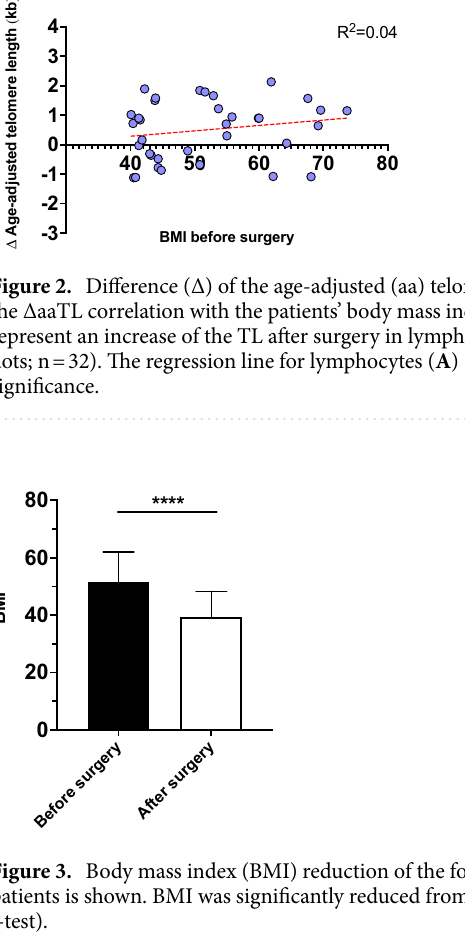
Fig. 1A (lymphocytes; blue dots) and Fig. 1B (granulocytes; yellow dots), compared to healthy individuals shown as percentile curves as used in previous publications 42,44 . No patient showed TL below the 1st percentile as a potential indicator of an inherited TBD. Compared to healthy controls, the lymphocyte aaTL of all patients before surgery was significantly shortened (-0.37 kb ± 0.18 kb, P = 0.045; Fig. 1C), while the granulocyte aaTL was not different (0.28 kb ± 0.17 kb, P = 0.11; Fig. 1C). Moreover, the lymphocyte TL was significantly shorter than that of the granulocytes (mean difference 0.65 kb ± 0.23 kb, P = 0.0041, Fig. 1C). Healthy individuals also had shorter TLs in lymphocytes than in granulocytes (data not shown). No correlation between preoperative BMI and the difference (Δ) in aaTL in lymphocytes (R 2 = 0.04, P = 0.28) or granulocytes (R 2 = 0.04, P = 0.26) could be detected (Fig. 2).